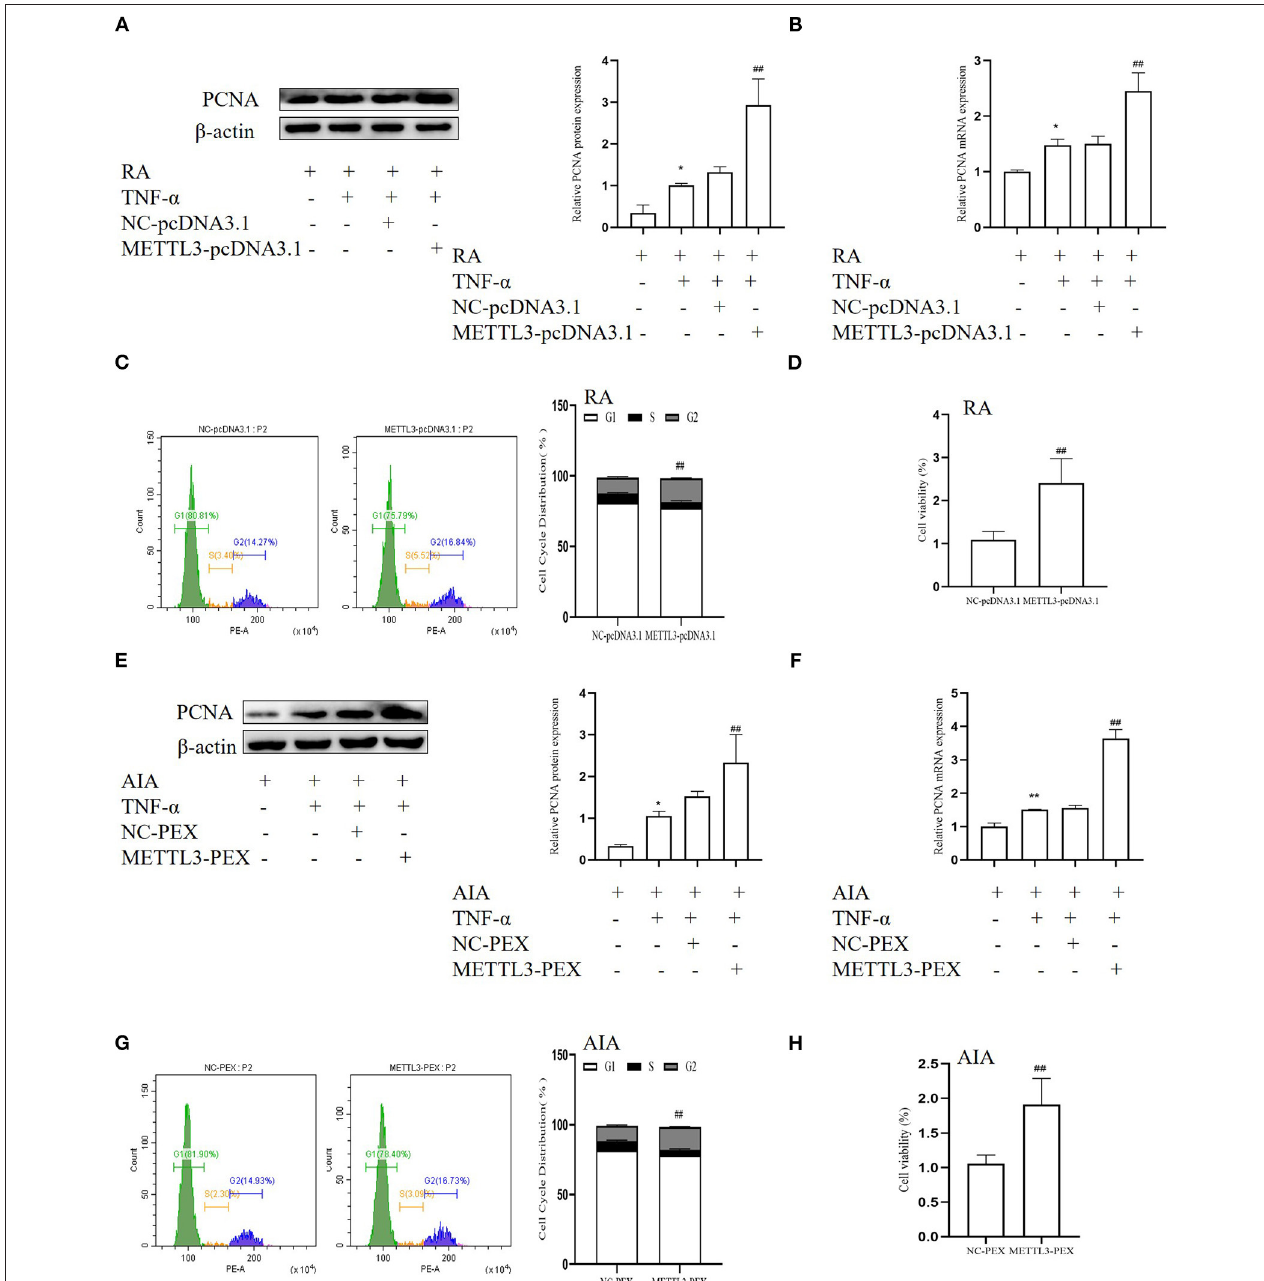
FIGURE 6 | Effect of methyltransferase-like 3 (METTL3) overexpression increases fibroblast-like synoviocyte (FLS) proliferation. (A) Proliferating cell nuclear antigen (PCNA) protein levels in TNF- α -incubated rheumatoid arthritis (RA)-FLSs after METTL3-pcDNA3.1 transfection, as detected by Western blotting. (B) PCNA mRNA level was detected by real-time quantitative PCR (qPCR) in TNF- α -incubated RA-FLSs after transfection with METTL3-pcDNA3.1. (C) Cell cycle analysis after transfection with METTL3-pcDNA3.1 for 48h, as detected by fluorescence-activated cell sorting (FACS). (D) Cell growth was measured by the 3-(4,5-dimethylthiazol-2-yl)-2,5-diphenyltetrazolium bromide (MTT) assay after transfection with METTL3-pcDNA3.1 for 48h in TNF- α -incubated RA-FLSs. (E) PCNA protein levels in TNF- α -incubated adjuvant-induced arthritis (AIA)-FLSs after METTL3 overexpression, as detected by Western blotting. (F) PCNA mRNA level was analyzed by qPCR after transfection with METTL3-PEX in TNF- α -incubated AIA-FLSs. (G) Cell cycle analysis was measured by FACS after METTL3 overexpression for 48h. (H) Cell growth was analyzed by the MTT assay after transfection with METTL3-PEX for 48h in TNF- α -incubated AIA-FLSs. All of these values are presented as the mean ± SD. NC , negative control. * P < 0.05, ** P < 0.01 vs. the control group. ## P < 0.01 vs. the NC